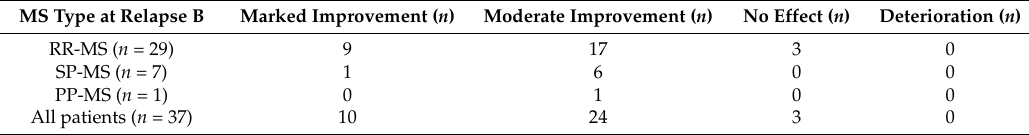
Table 5. Clinical response to GCS treatment for relapse B in patients with